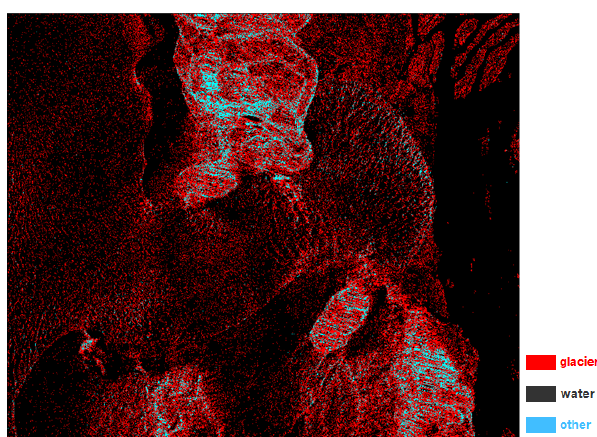
Figure 8. Classification result only using SAR data. Red colour: glacier area; Black colour: non-glacier area; Blue colour: the